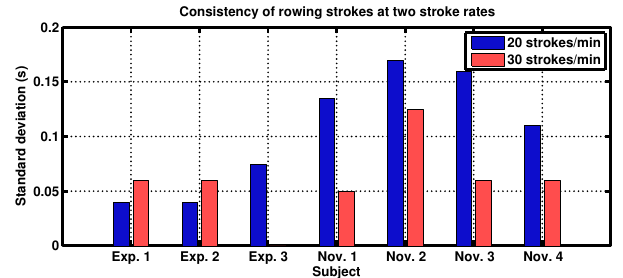
Figure 5: Overview of stroke time consistency.